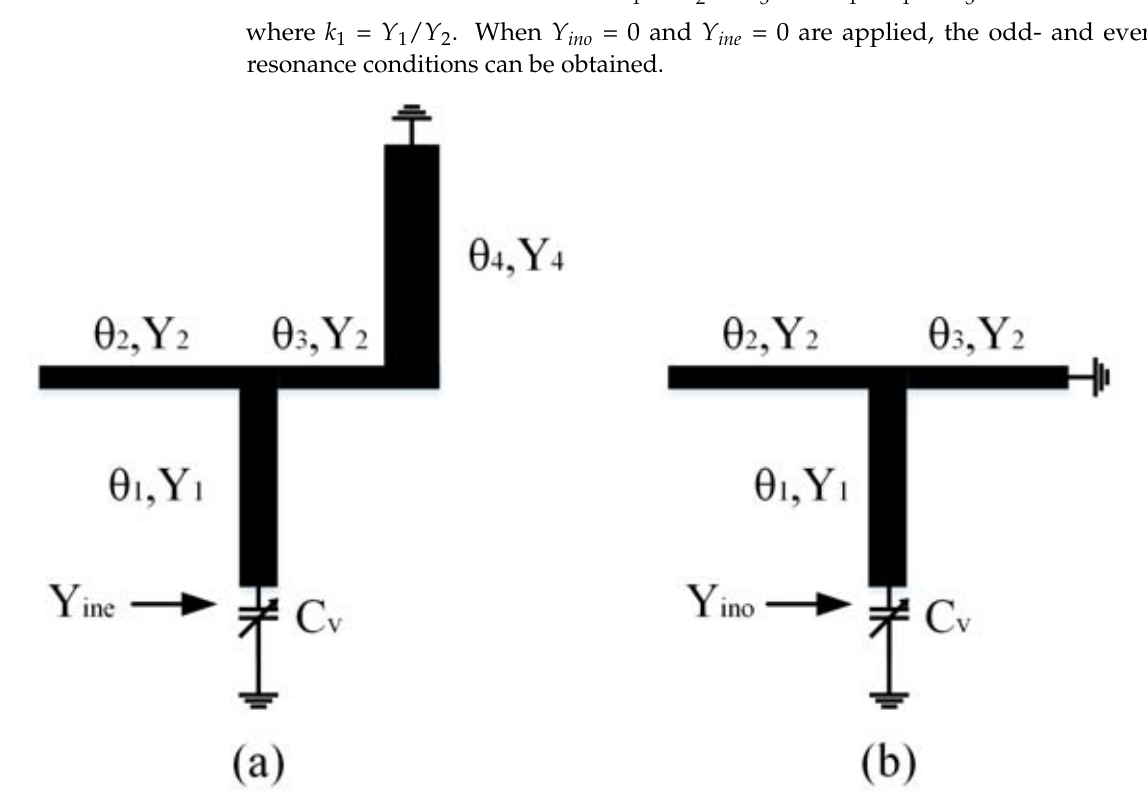
Figure 2. A simplified equivalent circuit model of the dual-mode resonators (DMR) proposed in this study. ( a ) Even mode; ( b ) odd mode.